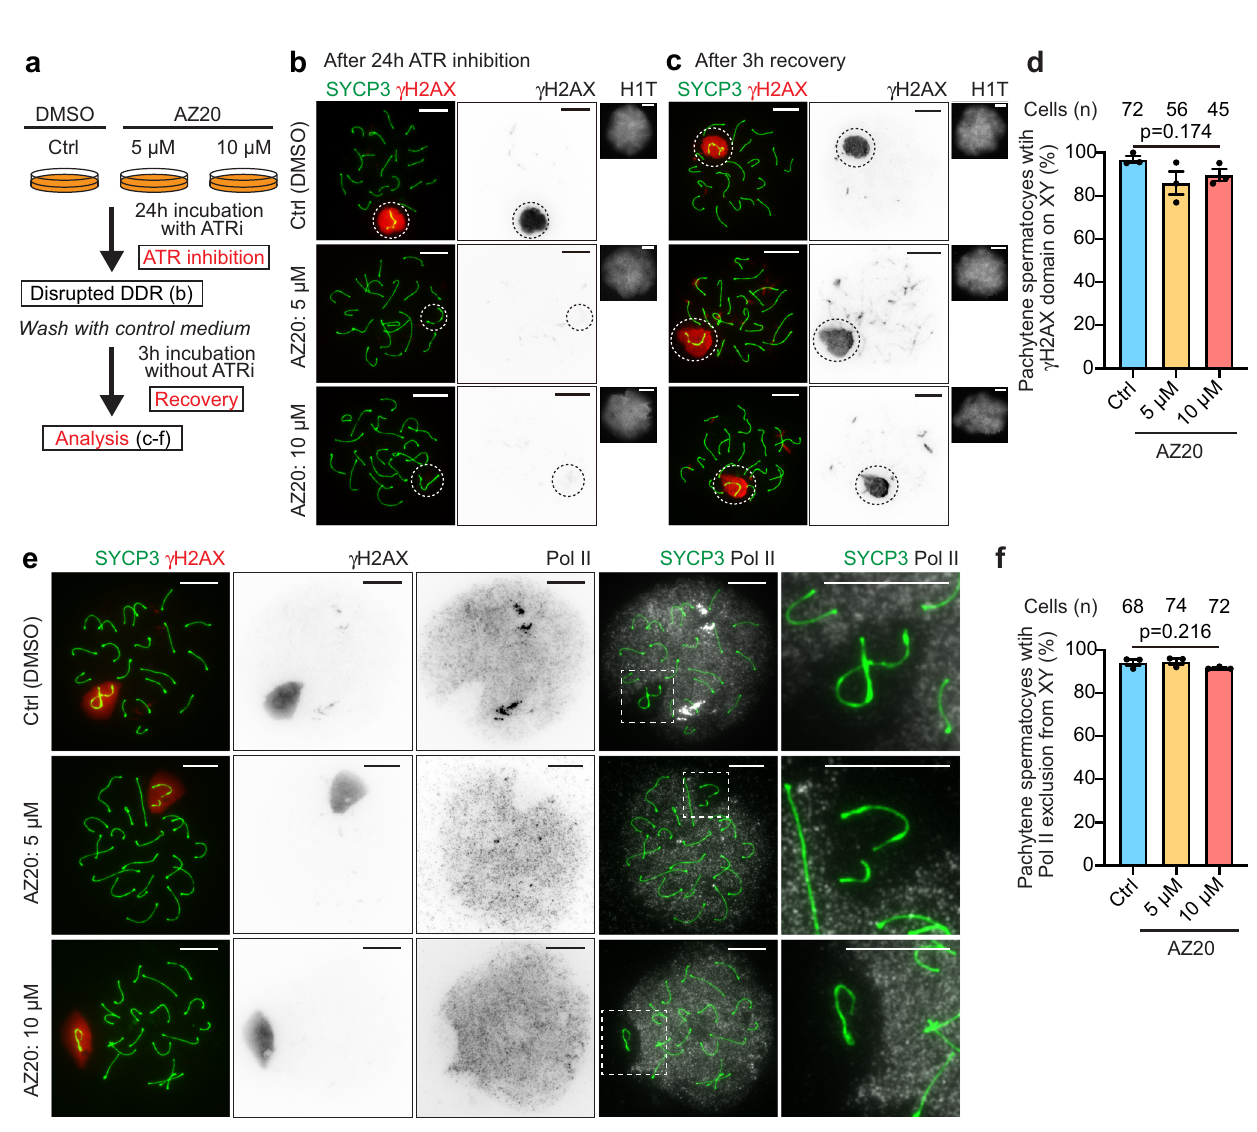
Fig. 4 | DDR-dependent MSCI is reversible. a Schematic of the experimental design. Spermatocytes were incubated for 3h without ATRi, which was removed after a 24h incubation with the ATRi AZ20. b , c Chromosome spreads of mid-late pachytene spermatocytes immunostained with antibodies raised against SYCP3, γ H2AX, and H1T; after treatment with 5 or 10mM AZ20 for 24h ( b ), and after an additional3hwithoutATRi( c ).XYchromosomesareindicatedwithdashedcircles. Representative images of 3 independent experiments are shown. d Quanti fi cation of mid-late pachytene spermatocytes withnormal γ H2AX domains on the XY after recovery from ATRi, as determined in comparison to untreated spermatocytes,